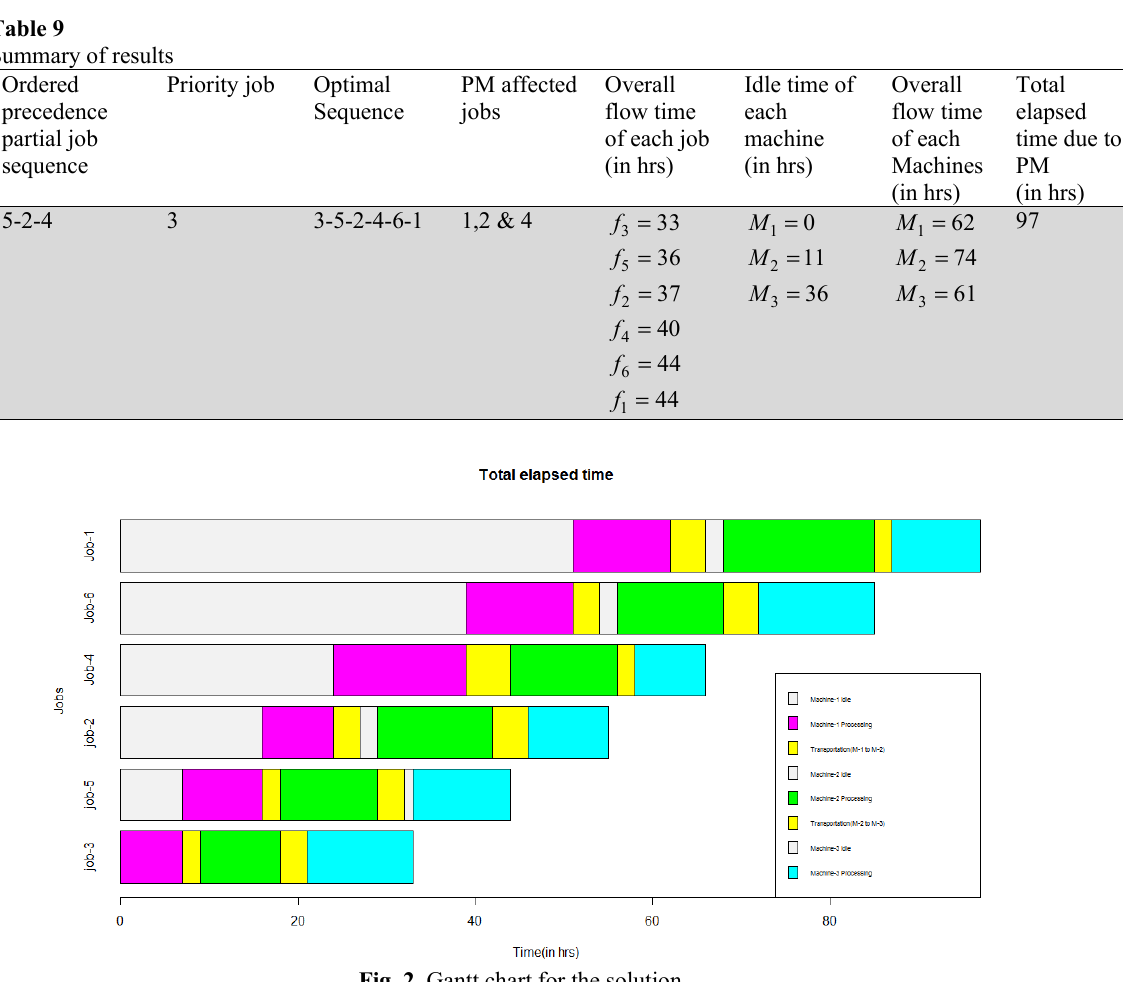
Fig. 2. Gantt chart for the